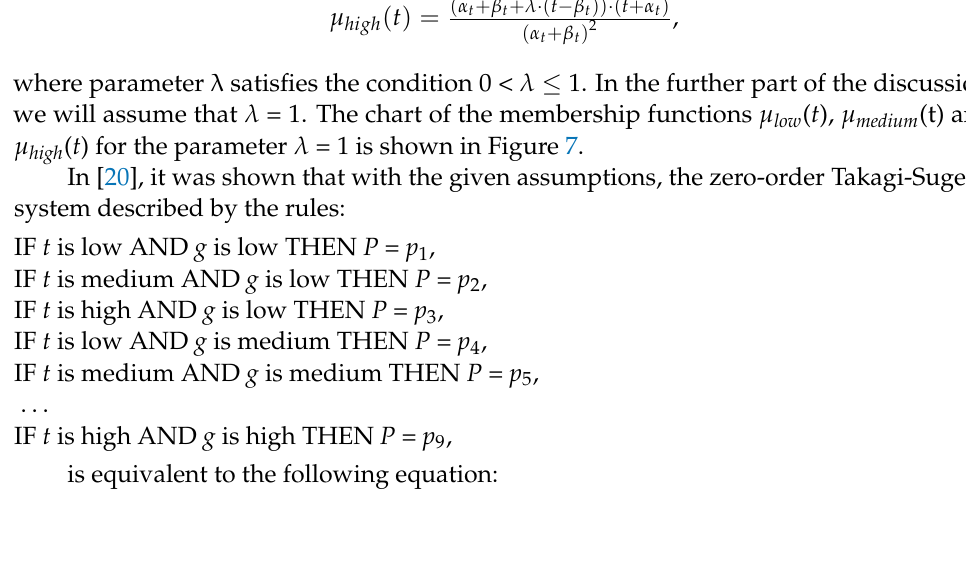
Table 4. Parameters of Equation (18) calculated from the training data set.